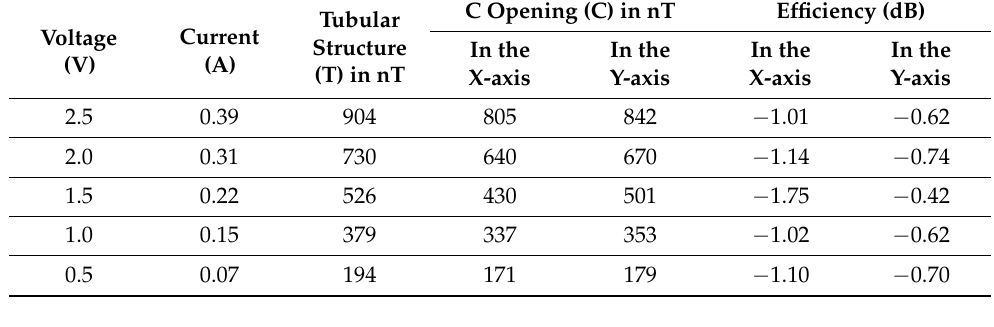
Table 2. Results of electromagnetic fields (peak value) in the C-shaped high-permeability material.